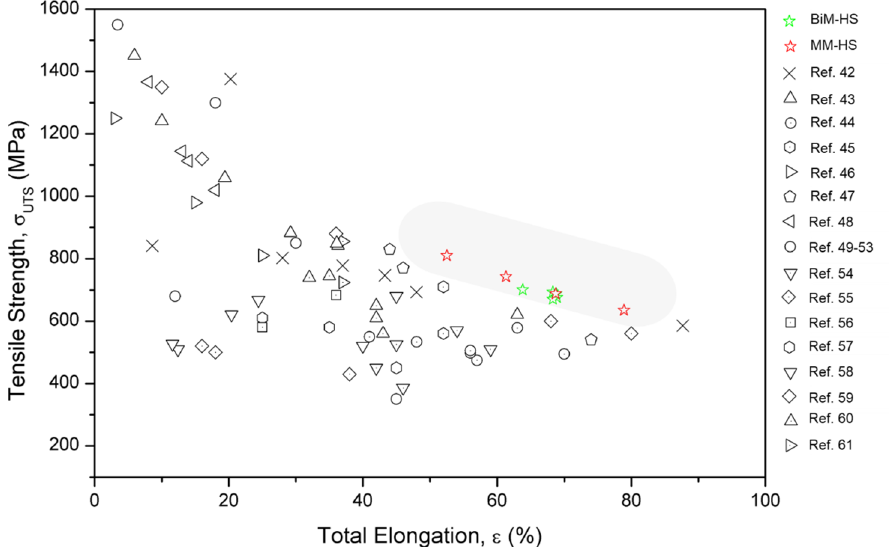
Figure 8. Ultimate tensile strength versus total elongation chart for HS SUS316L compacts, and their comparison with SUS316L counterparts produced by various methods [42–61].